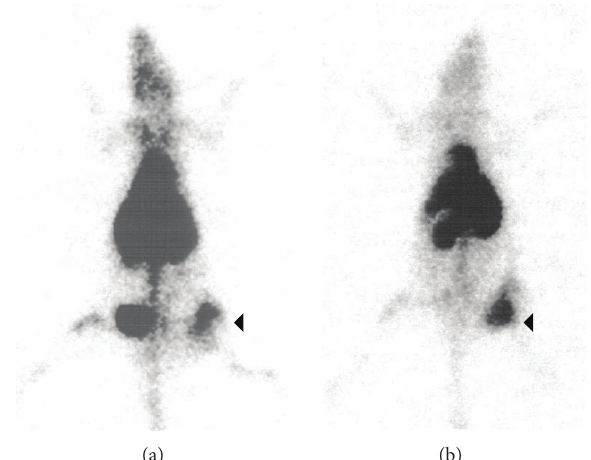
Figure 5: Whole body images of rats with S. aureus infections ( 󳶣 ) in left thigh at 4 hours pi with (a) 99 m Tc-hIgG and (b) 99 m Tc-rIgG.